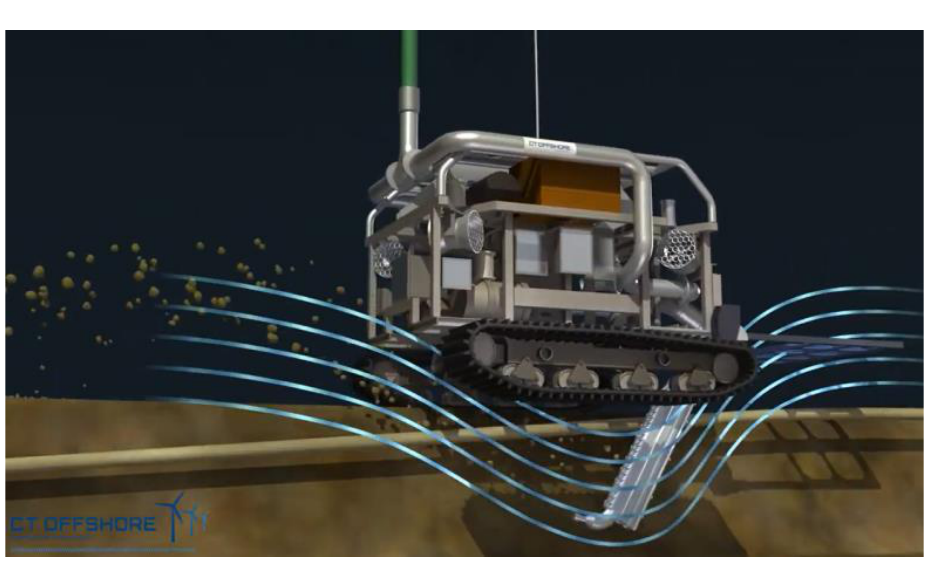
Figure 4. Example of subsea cable burial by jetting. Source: CT